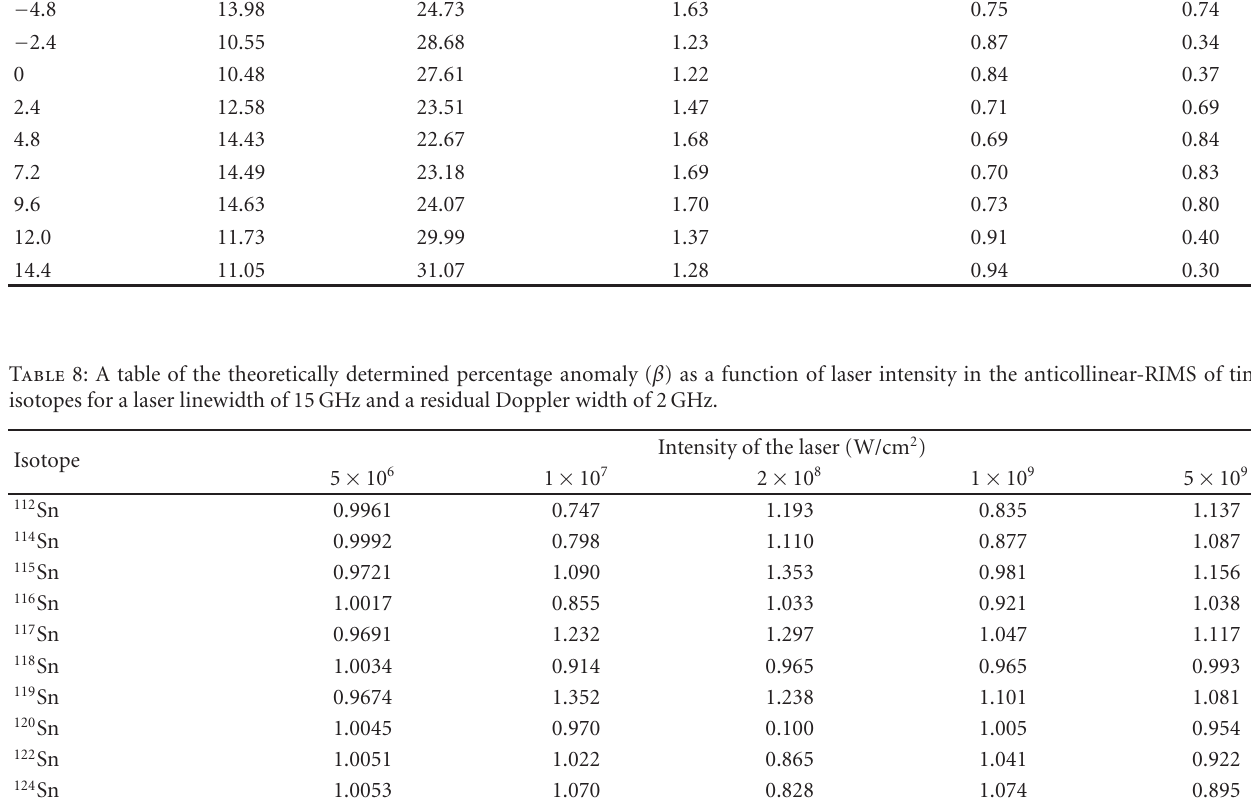
Table 7: A table of the experimentally determined abundances and responses of the odd and even isotopes. Experimentally determined anomaly ( β ) as a function of laser frequency detuning for collinear-RIMS.